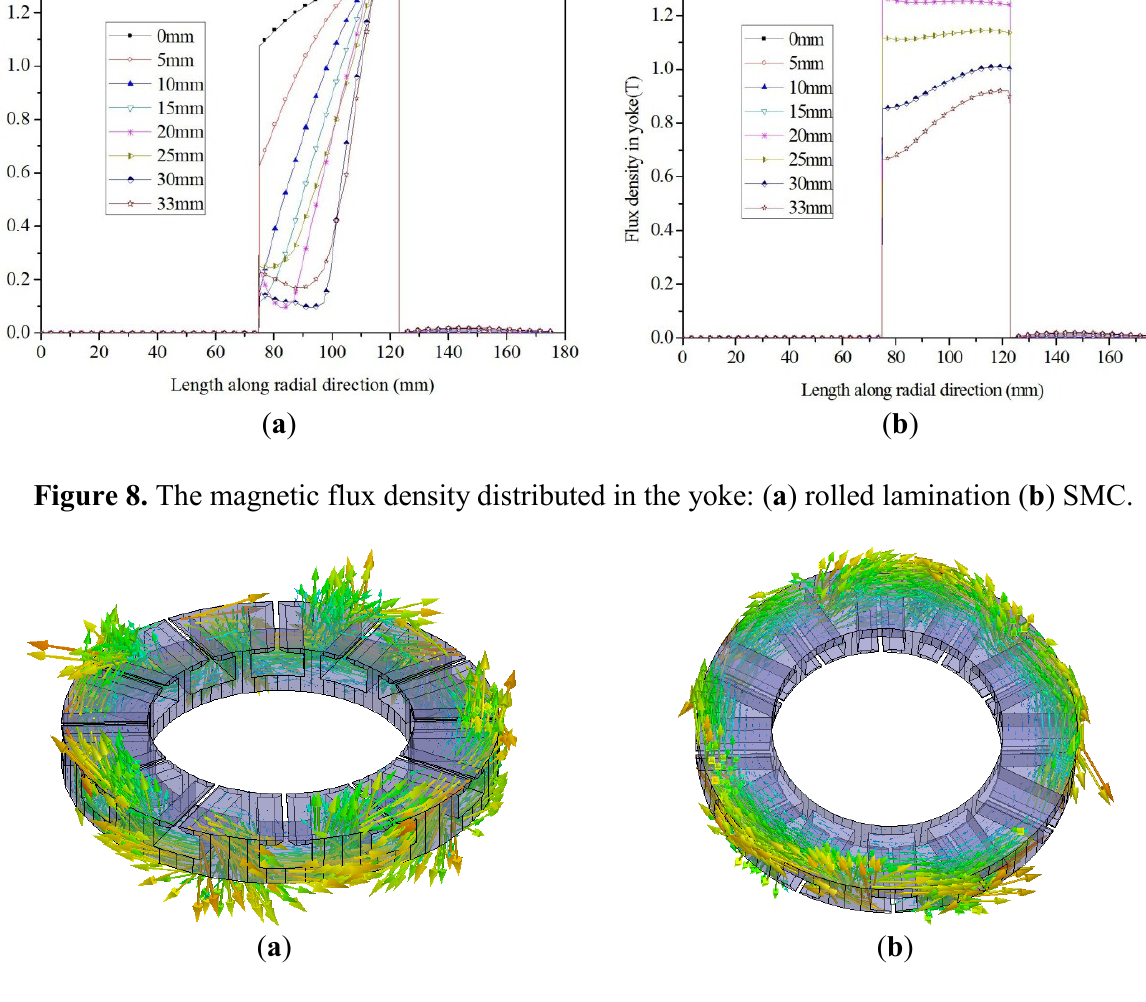
Figure 9. 3D distribution of magnetic flux density in the rolled laminated stator when PMs sliding outward: ( a ) view from teeth side, and ( b ) view from yoke